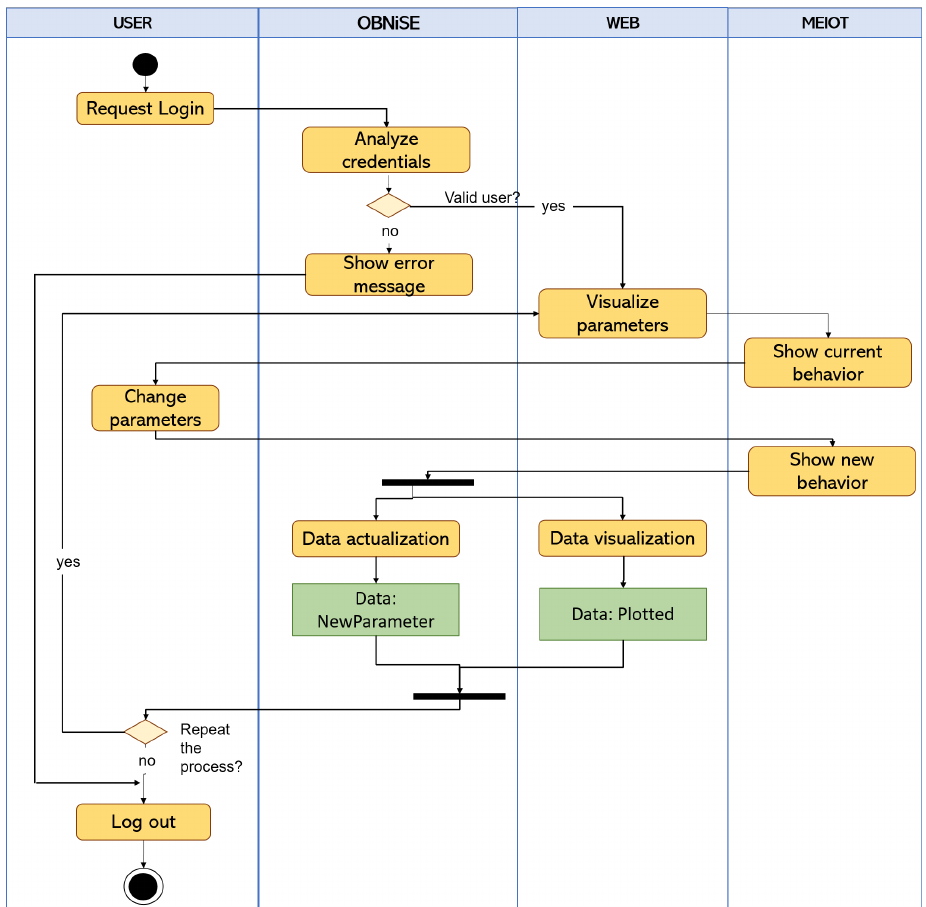
Figure 11. Activity diagram between participants, the web system, and the MEIoT weather